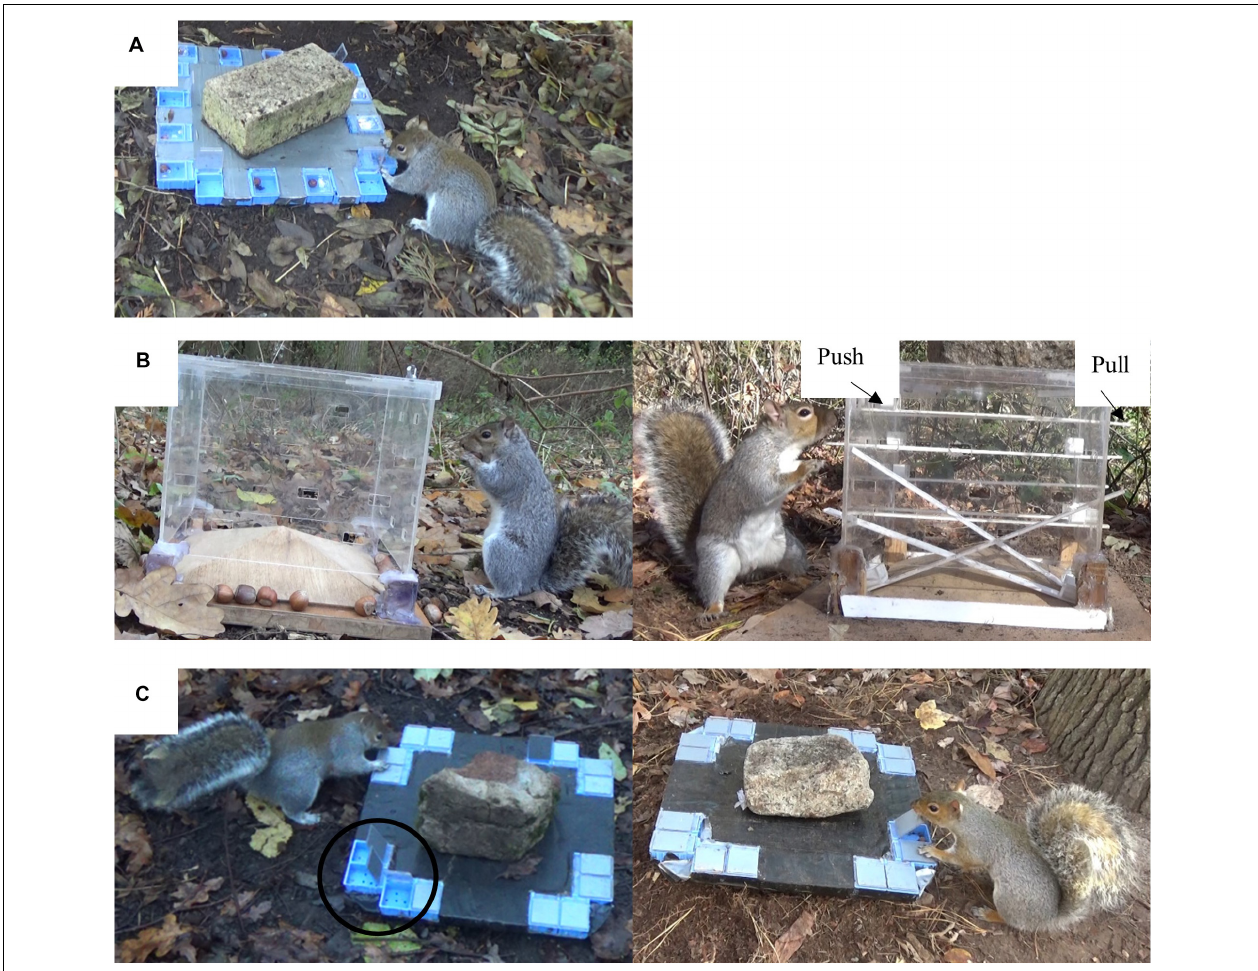
FIGURE 1 | Four tasks that are used to measure flexibility and cognitive performance: Two innovation tasks that include (A) the easy problem that requires a squirrel (X-23 is shown in the image) to lift up a transparent lid using its teeth to solve the problem, and (B) the difficult problem that required a squirrel (Iron Fist shown in the image) to use its nose to cause a lever and/or nut drop by pushing a lever-end that was close to the reward. The left image shows the transparent Plexiglas box during the habituation phase (without levers) whereas the right image shows the box during the main testing (with 10 levers). Also shown are the two cognitive tasks that include (C) the spatial-learning task in which a squirrel had to associate locations with rewards (Quick Silver is shown in the right image). The left image shows the five holes (in dark circles) at the bottom of each container where inaccessible nut pieces were used to control squirrels use of olfactory cues during locations-rewards learning. Rewarded containers were baited at diagonal corners (total 8 containers) to control side bias. The recall test was the same difficult problem in (B) presented to squirrels 25 days after their last experience it.